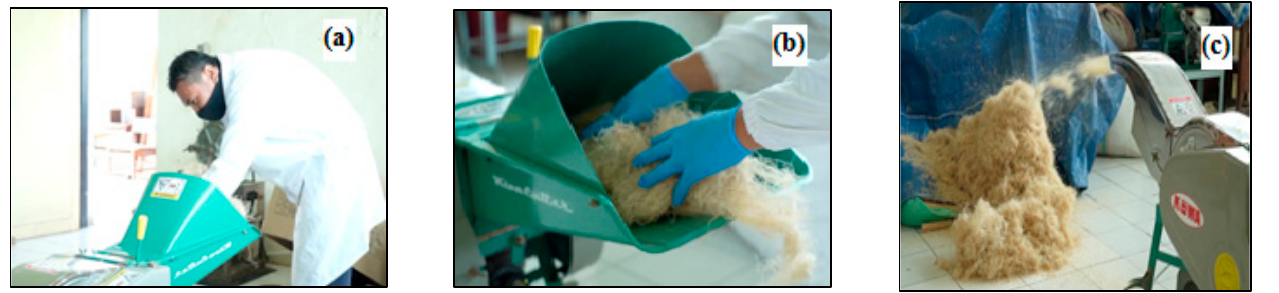
Figure 3. ( a ). WEFB fiber and SEFB fiber are cut using a cutting machine; ( b ). The cutting process is performed manually slowly to obtain good cutting results; ( c ). The long fibers that have been cut have a size of about 2–3 cm.